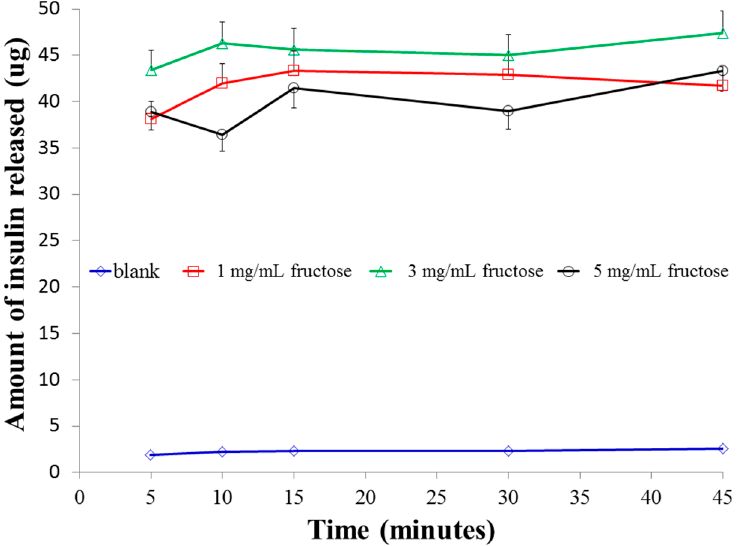
Figure 5. Release profiles of insulin from F3PN in various concentrations of phosphate buffered fructose solutions.